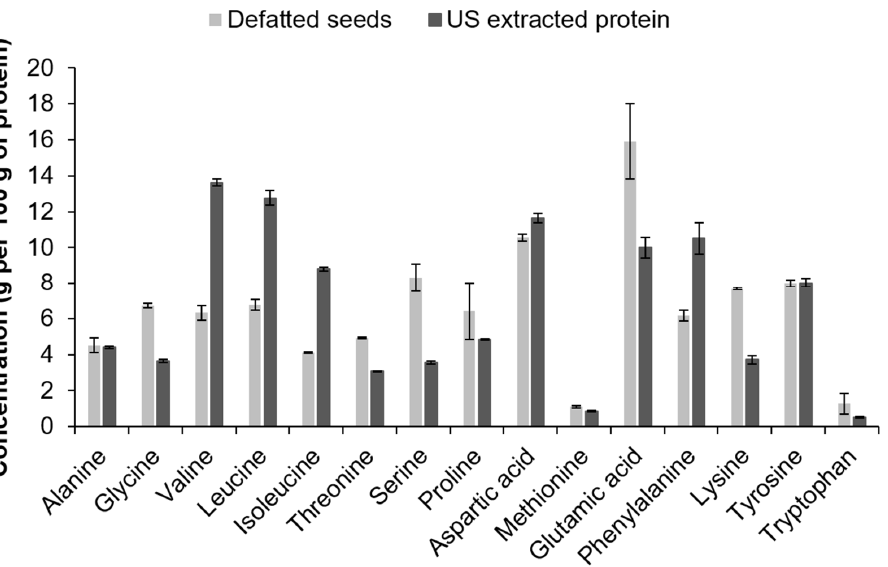
Figure 2. Amino acid pro fi le of African oil bean seed protein and protein isolates extracted by ultrasonication. Extraction conditions: 50 °C, 15 µm, 60 min.